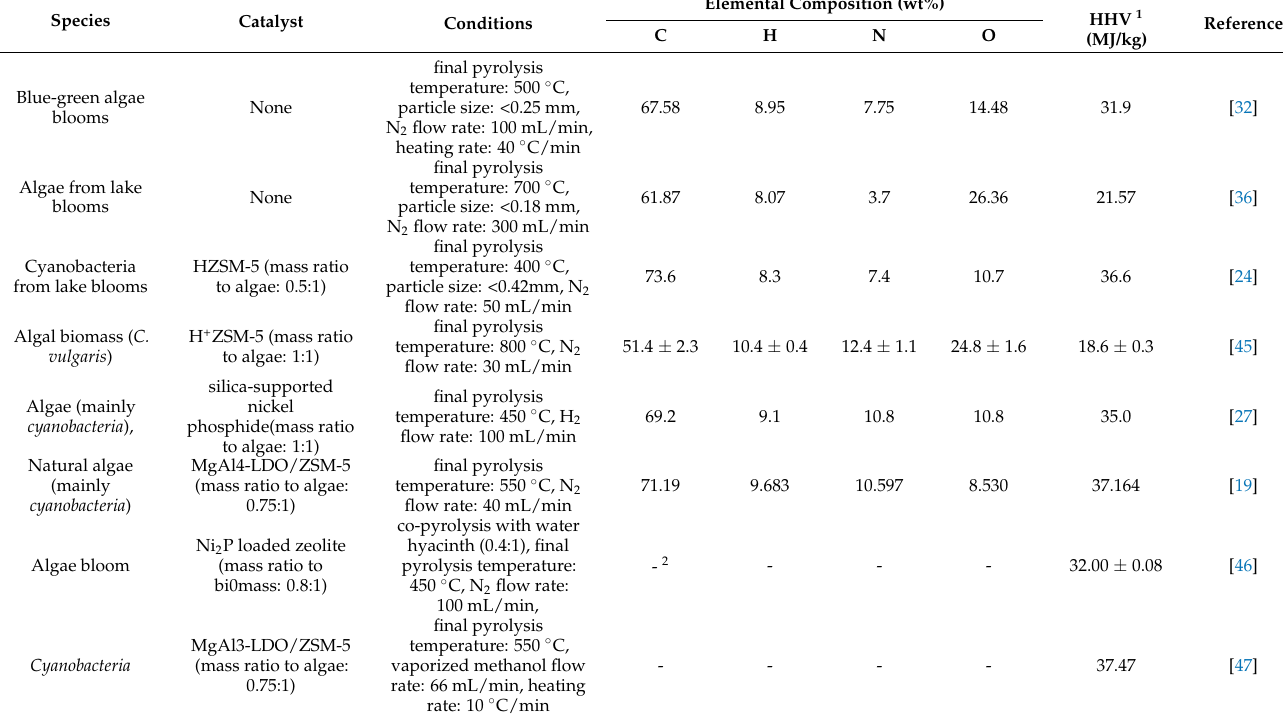
Table 2. Properties of the pyrolysis bio-oil obtained from natural